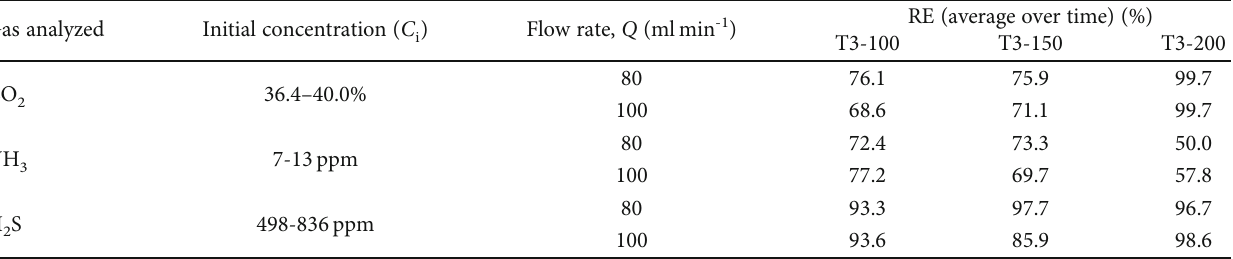
Table 4: E ff ect of soil mass and biogas fl ow rate on the bio fi lter T3 performance; H over 2-hour operating